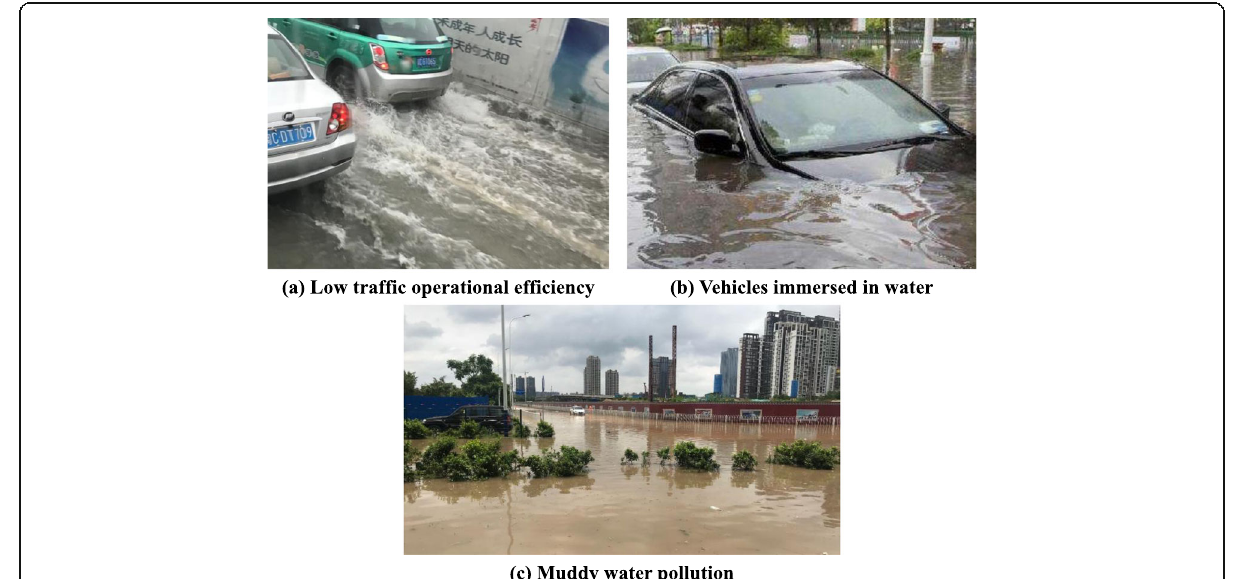
Fig. 1 Urban waterlogging caused by intense rainfall in Guangdong